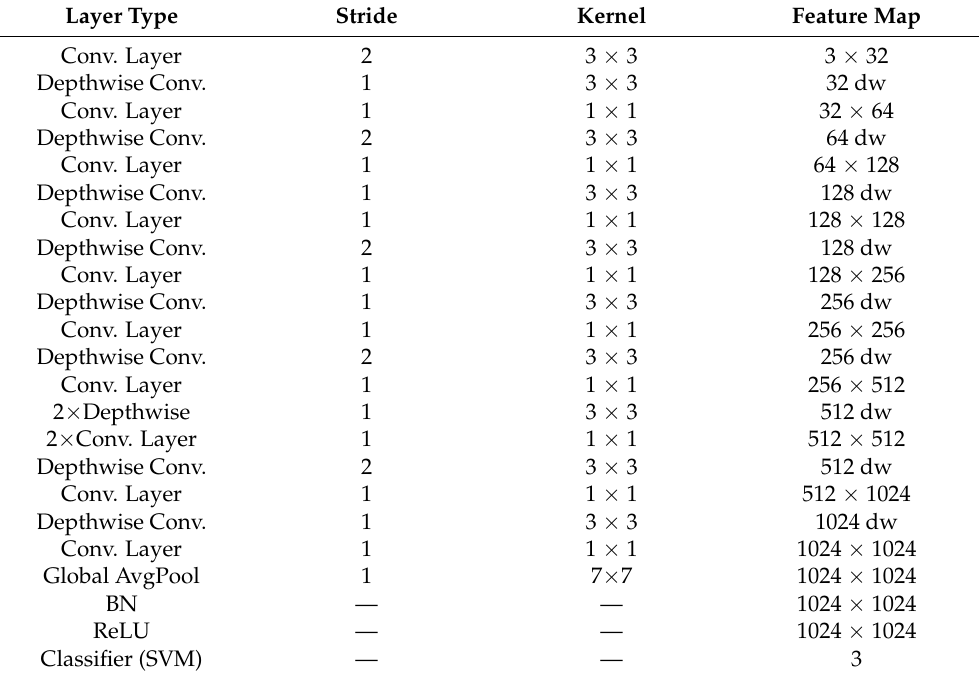
Table 1. Parameters distributed in HDM-NET with classifiers (SVM), dw means